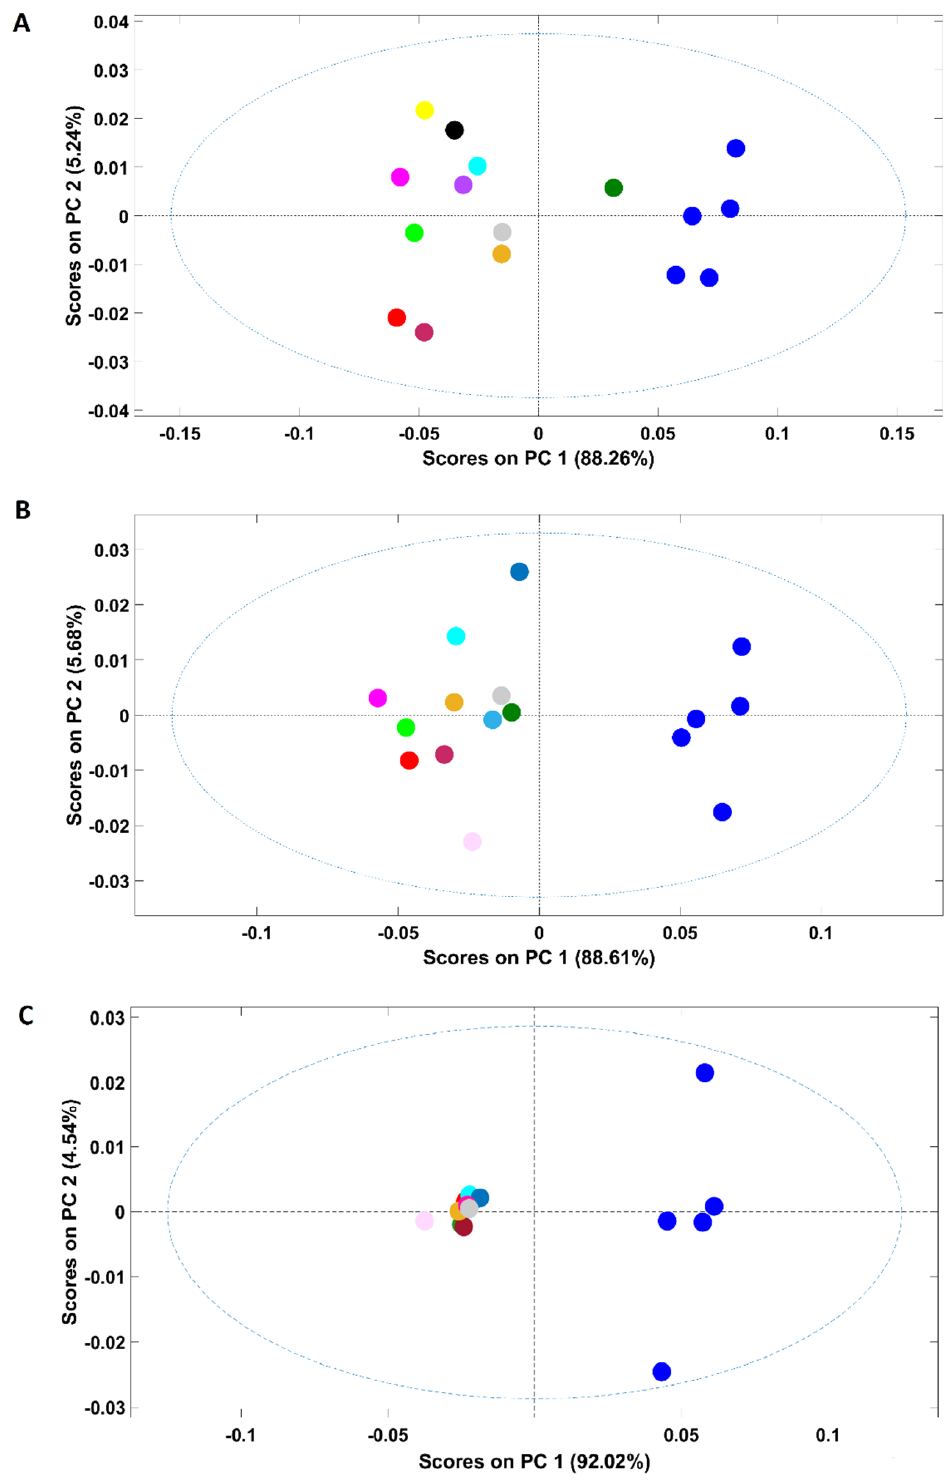
Figure 5. Scores plot of the PCA model developed with samples containing distinct percentages of adulterants: ( A )—20%; ( B )—10%; ( C )—1%. Legend:  pure arabica;  robusta;  corn;  coffee husks; adulterants: ( A )—20%; ( B )—10%; ( C )—1%. Legend: • pure arabica; • robusta; • corn; • coffee